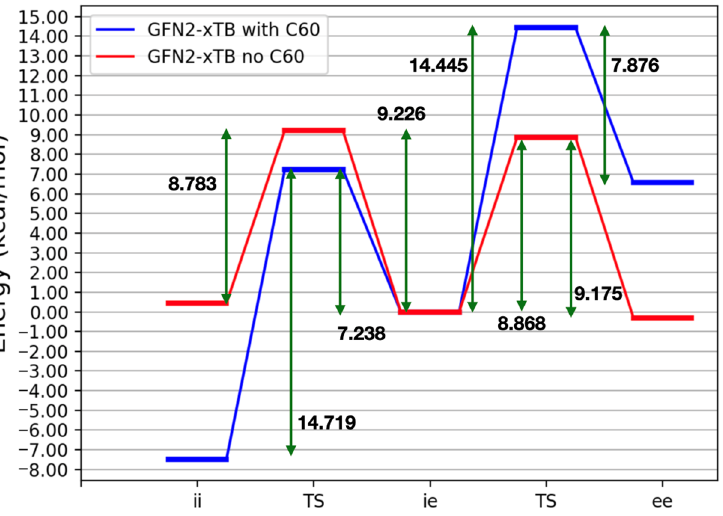
Figure 2. Energy (in kcal/mol) diagram for the interconversion of the corannulene pincer conformers with a molecule of 𝐶 (cid:2874)(cid:2868) within the pincer’s arms, according to GFN2-xTB. Only stationary points along the energy surface were